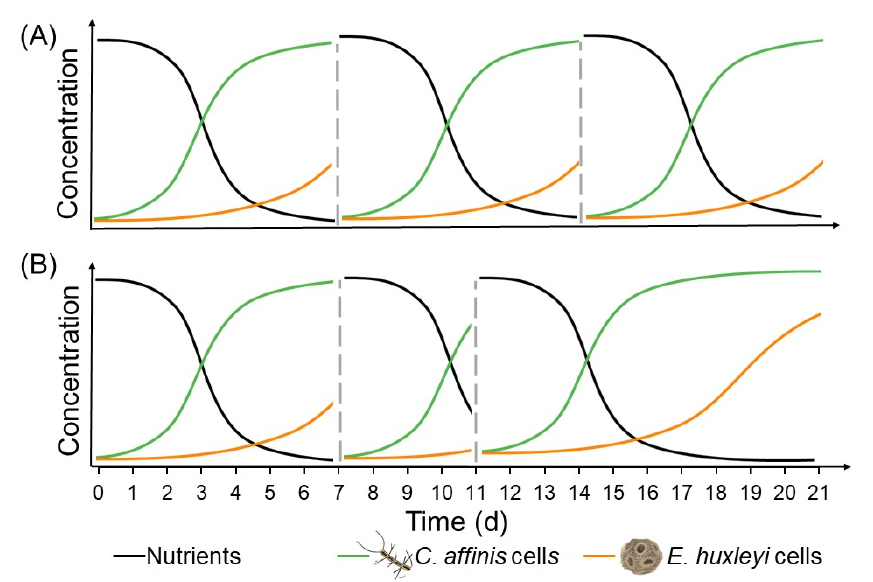
Figure 1. Schematic view of nutrient availability under ( A ) regular (transfer every 7 days; dashed grey lines indicate time of transfer) and ( B ) irregular (transfer after 7, 4 and 10 days; dashed grey lines) fluctuations and consequently changing temporal windows for species to thrive.